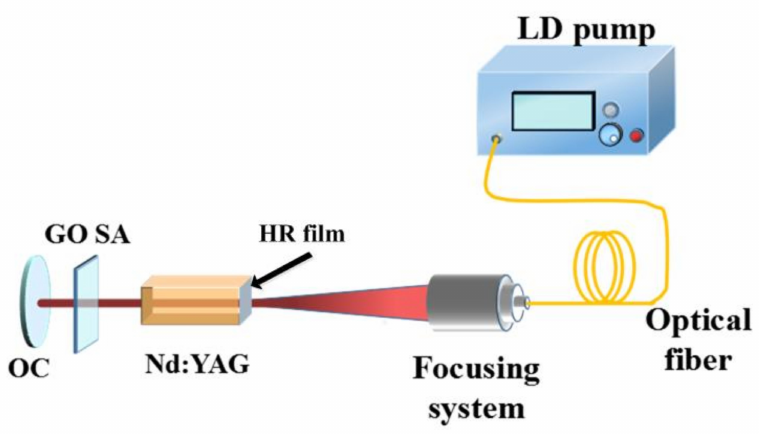
Figure 3. Experimental setup of passively Q-switched (QS) laser with GO